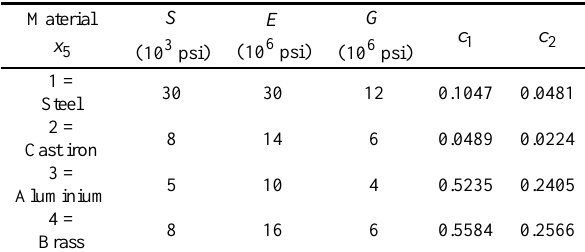
Table 8. Material properties for the 2nd variation of welded beam design problem.